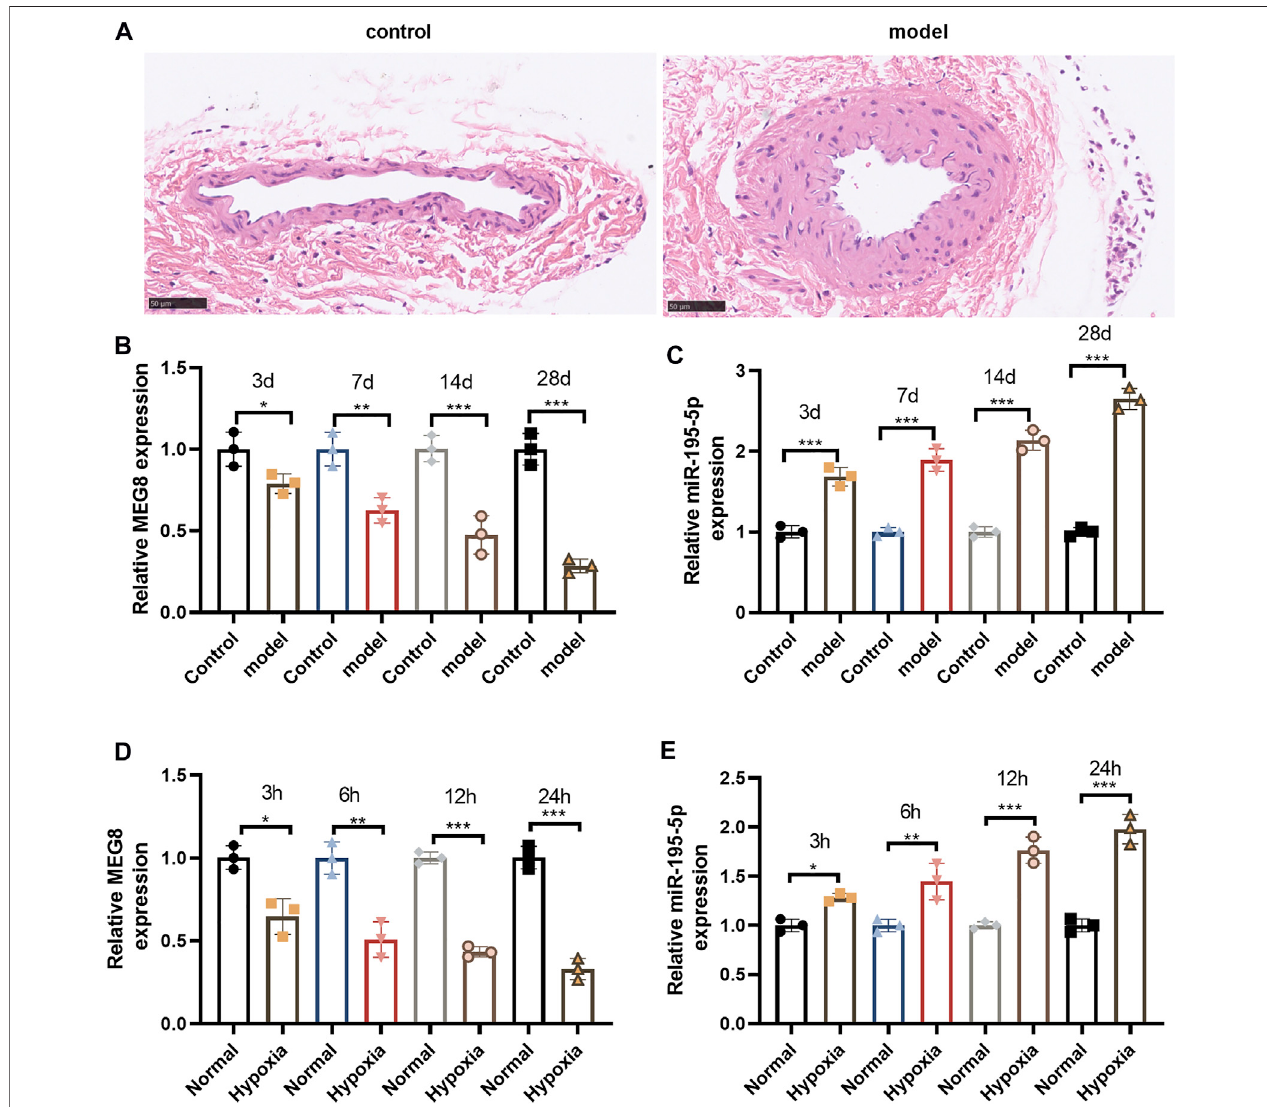
FIGURE1| MEG8waslowlyexpressedinthecarotidarteryofratswithballooninjury.ThecarotidarteryinjurymodelofSDratswasconstructedbyapercutaneous transluminal angioplasty balloon dilatation catheter. (A) H&E staining for detecting the histopathological changes of internal carotid 4 weeks after vascular intimal injury. (B,C) qRT-PCRcheckedtheexpressionofMEG8andmiR-195-5p inthecarotidarteryofrats. (C,D) qRT-PCRwasimplemented togaugetheexpressionofMEG8and miR-195-5p in A-10 cell lines treated with hypoxia. *, **, *** represents p < 0.5, p < 0.01 and p < 0.001 vs. control group or Normal group. Five rats were in each group. Each assay was performed in